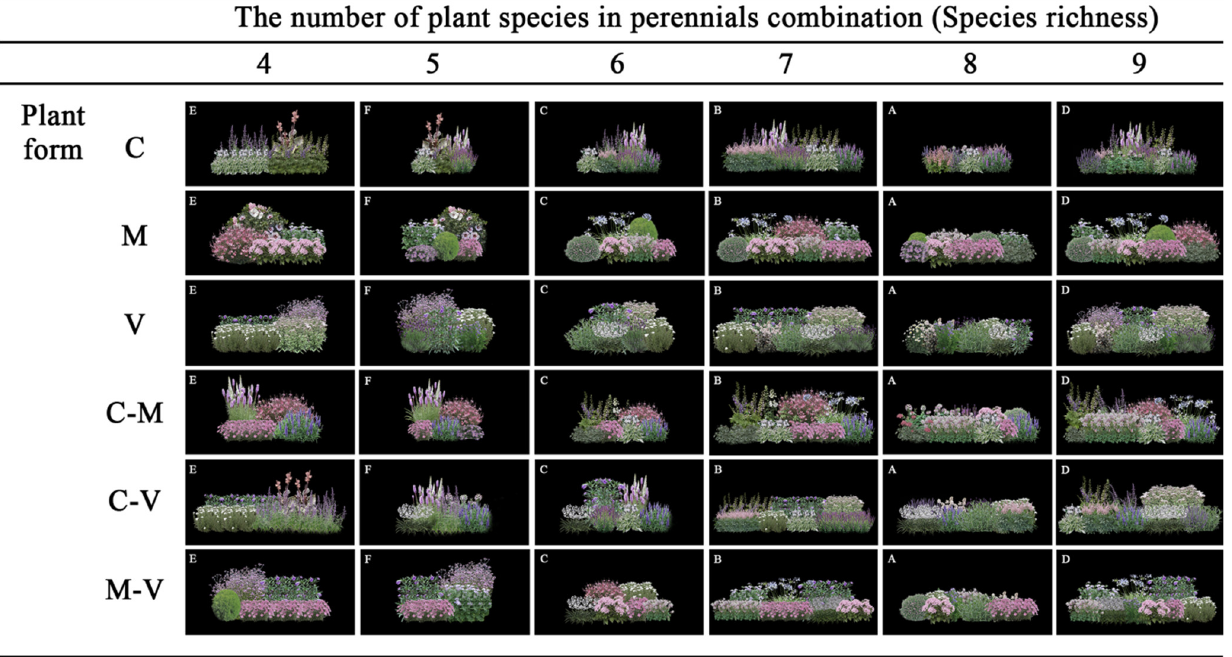
Figure 3. Presentation of the visual stimuli in experiment B. C, M and V represent conical, mounding and vertical, respectively. The letters in the upper left corner of each photomontage represent the plant arrangement patterns in Figure 1.